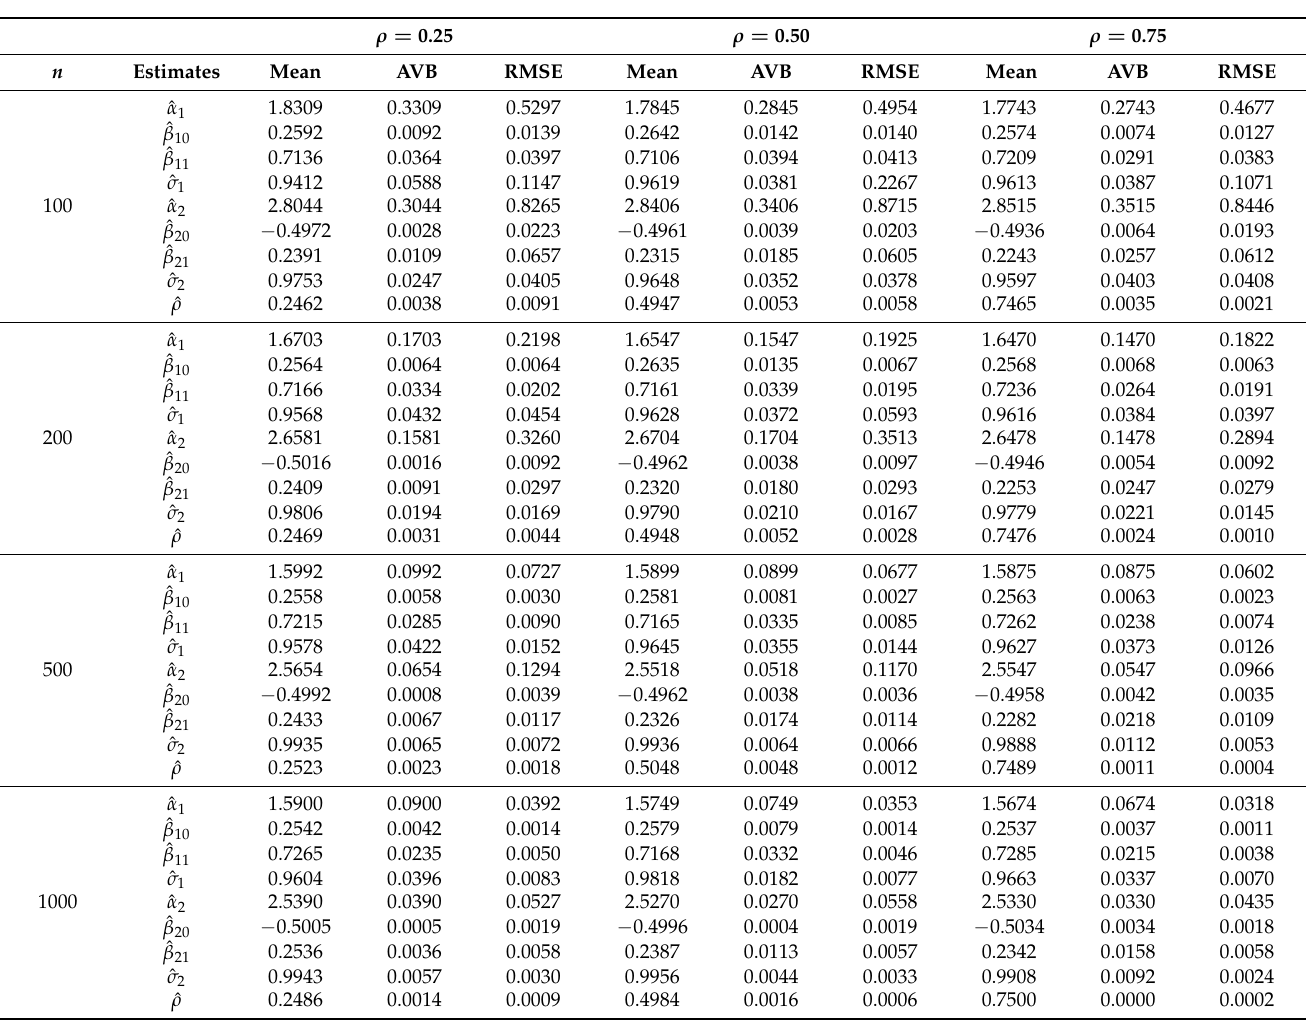
Table A2. Asymptotic behavior of the MLE for the BVSHN regression model with parameter